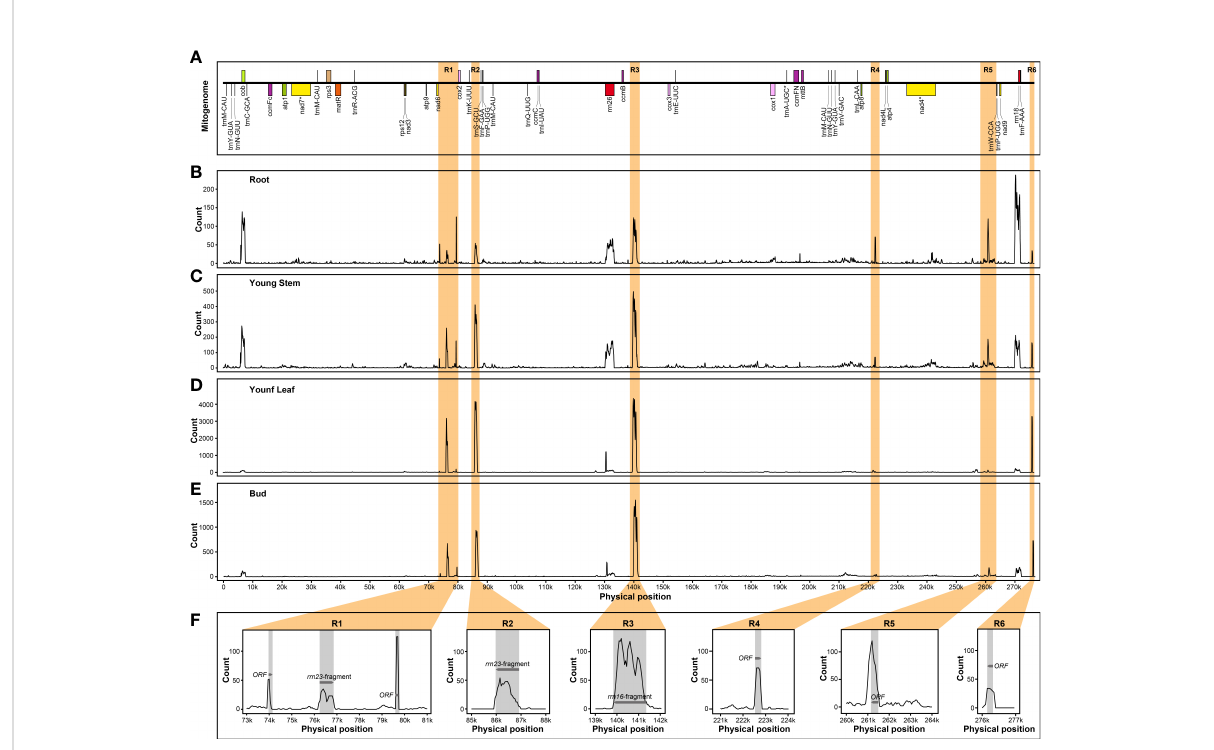
FIGURE 7 Transcript abundance of B monoica mitogenome transfer into nuclear genome in different tissues. R1 to R6 (orange regions) indicates six IGS with relatively high transcript abundance. (A) Liner annotation of B monoica mitogenome. (B – E) Count of RNA reads mapping to B monoica mitogenome in root, young stem, young leaf, and bud, respectively, using a 100-bp sliding window with a 50-bp step size. (F) Annotation of R1 – R6. Grey regions indicate annotated gene fragments or open reading frames (ORFs) and arrows indicate the transcriptional